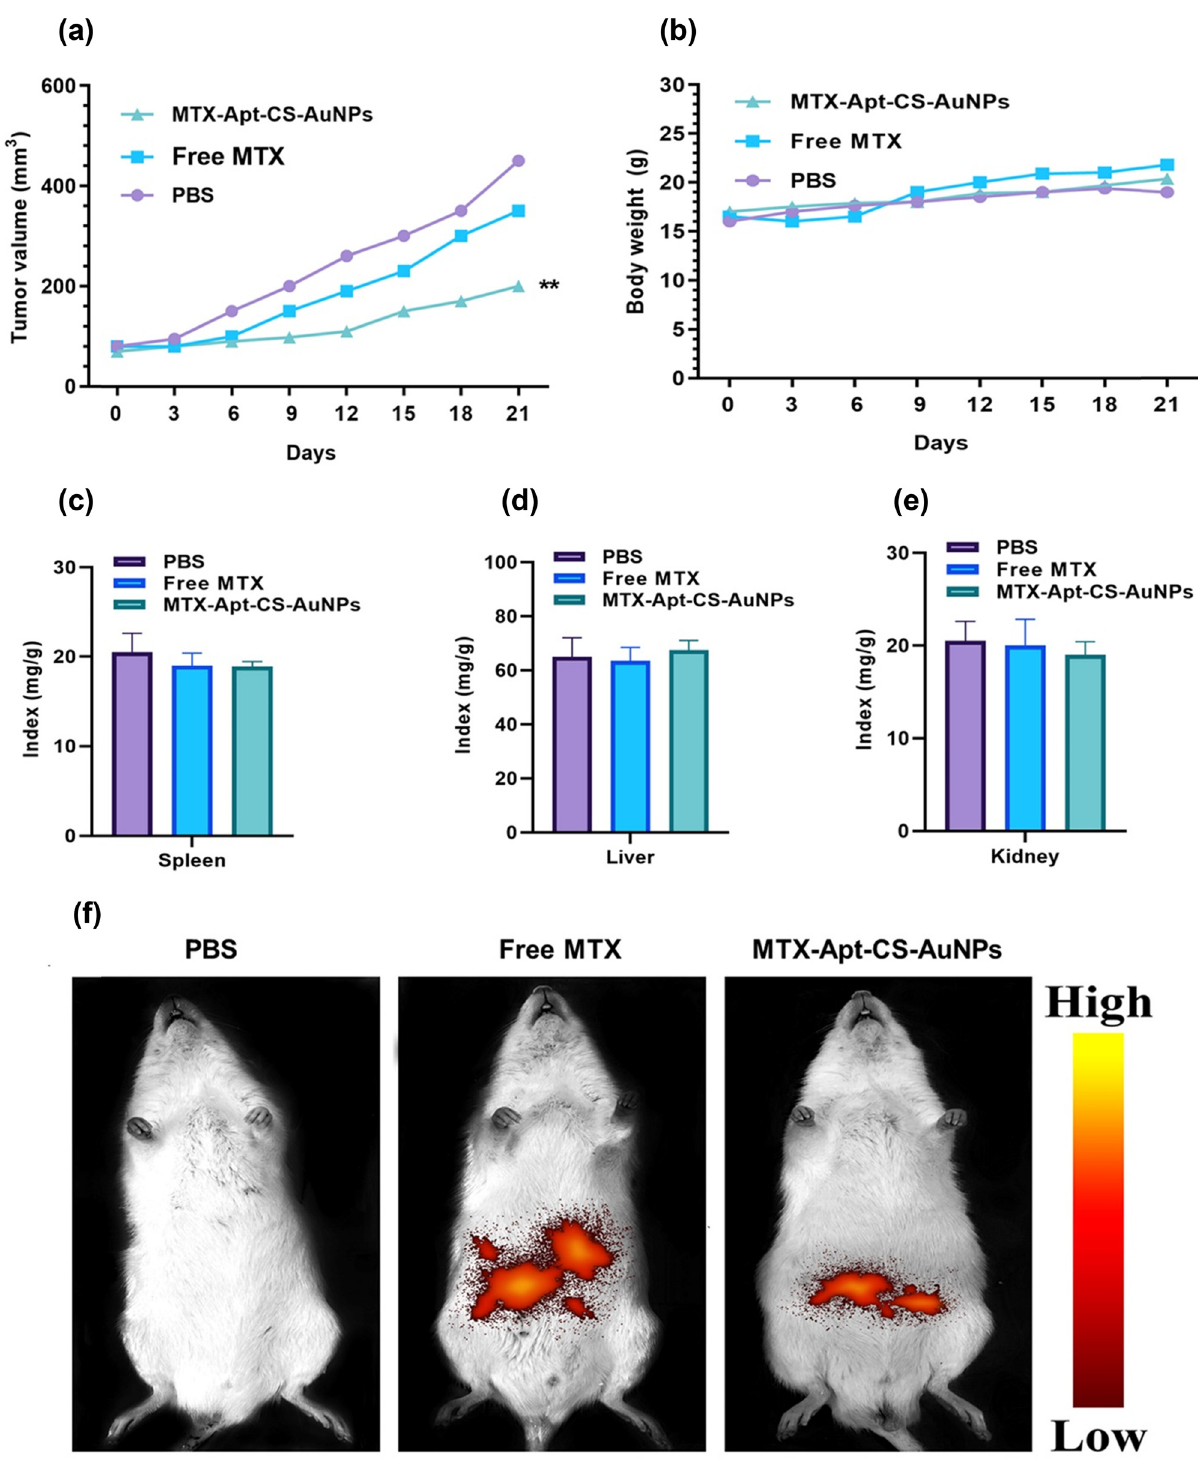
Figure 8: ( a ) Tumor size, ( b ) the bodyweight, and ( c – e ) the organ indexes ( liver, spleen, and kidney ) of mice after treatment with PBS, free MTX, and MTX - Apt - CS - AuNPs. ( f ) The fl uorescence intensities of mice after 4 h post injection with PBS, free MTX, and MTX - Apt - CS - AuNPs to monitor the targeting e ff ects. ** p < 0.01 shows signi fi cant di ff